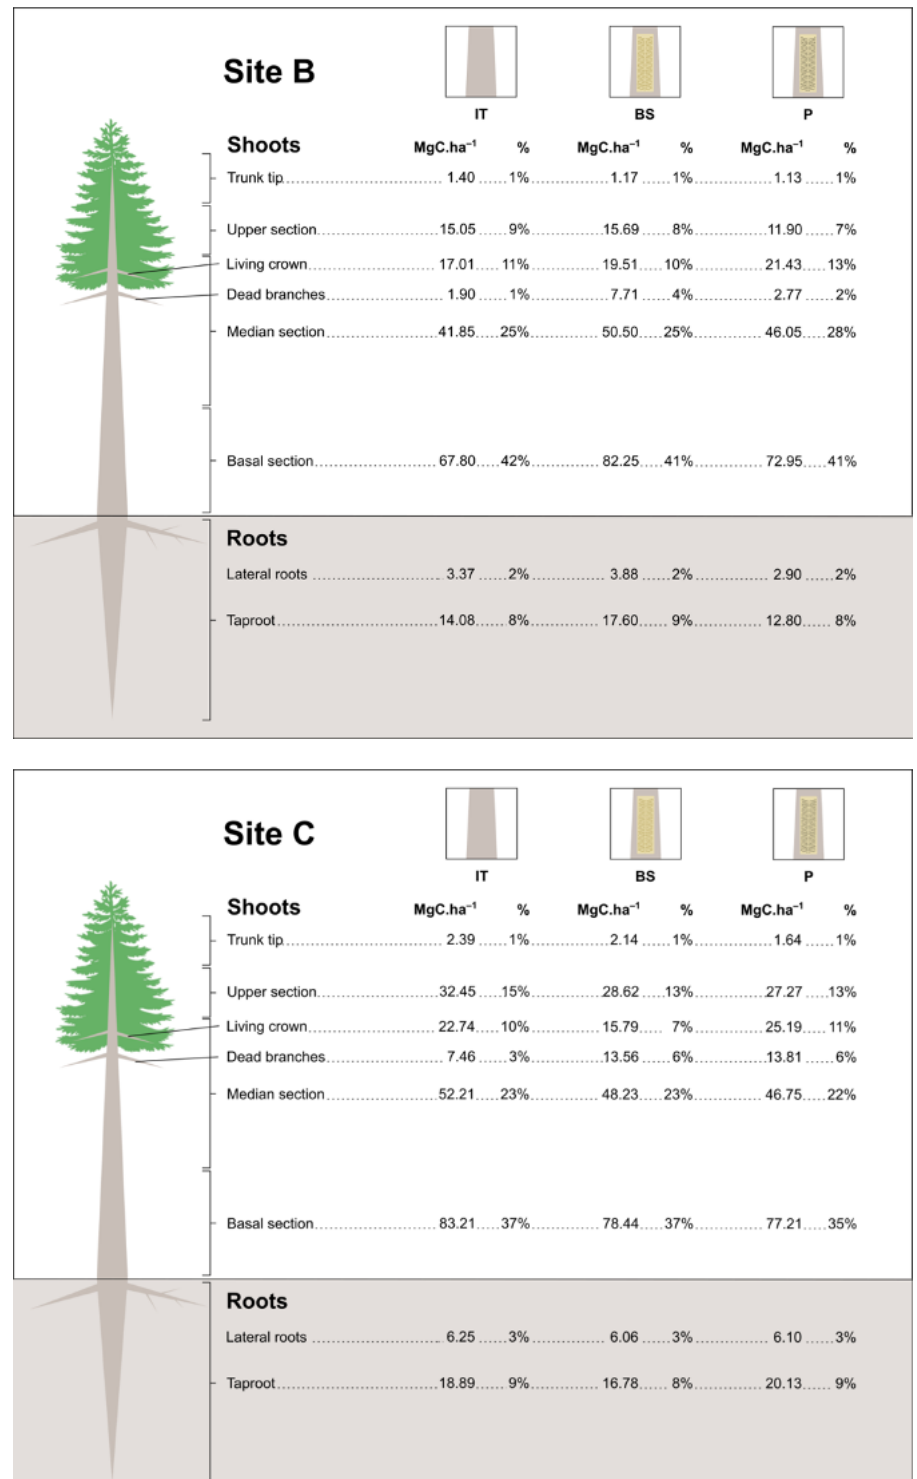
Figure 5. Biomass and C partitioning of slash pine trees growing at plantations of three different ages. Site A: 14-year-old, site B: 24-year-old, site C: 26-year-old (age at the installation of the experiments). Treatments: IT = Intact; BS = Bark Streak; P = Paste. The values for wood biomass (%) and carbon stock (MgC·ha −1 ) were calculated based on the biomass weight (kg) of 15 trees per treatment per pine stand (Year I). A living crown refers to live branches and leaves.